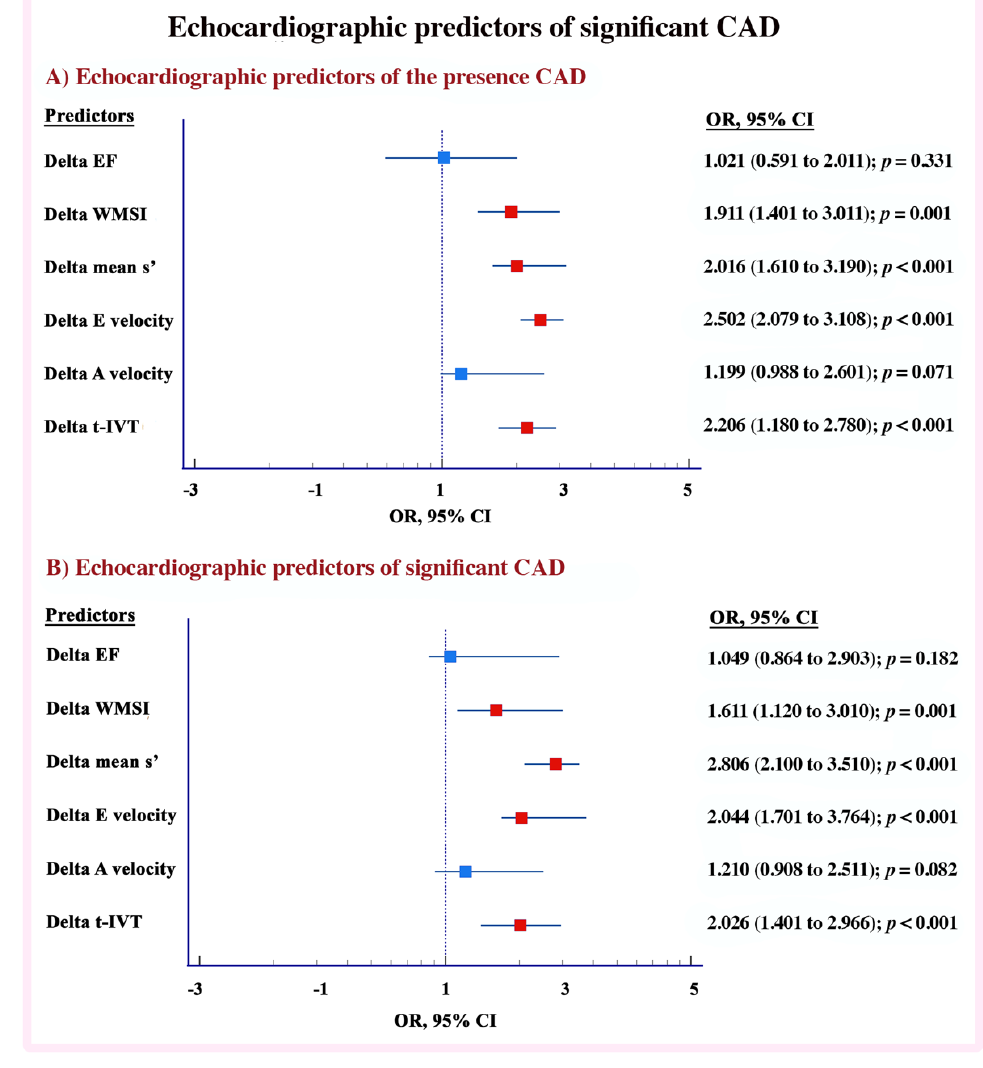
Figure 2. Echocardiographic predictors of significant CAD. ( A ) Echocardiographic predictors of the presence CAD. ( B ) Echocardiographic predictors of significant CAD.